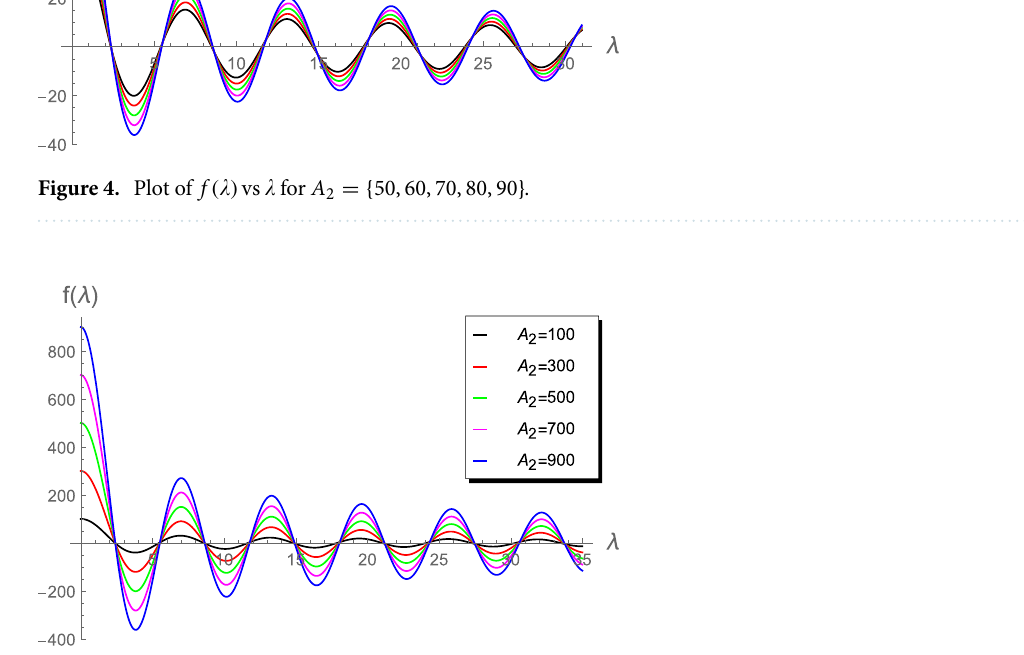
Figure 5. Plot of f ( (cid:31) ) vs (cid:31) for A 2 = { 100, 300, 500, 700, 900 }